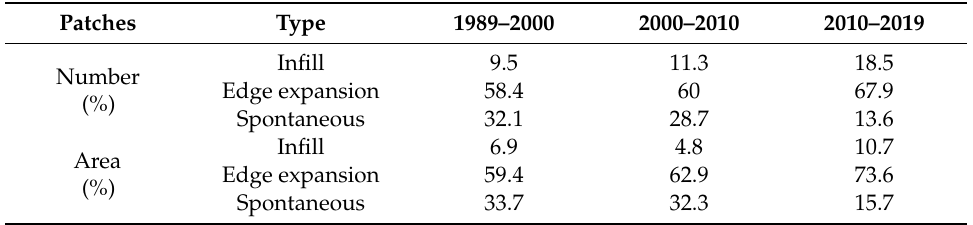
Table 8. Percentage values of number of patches and areas by type of building expansion (spontaneous, edge expansion or infill) in the three different periods (1989–2000, 2000–2010 and 2010– 2019).